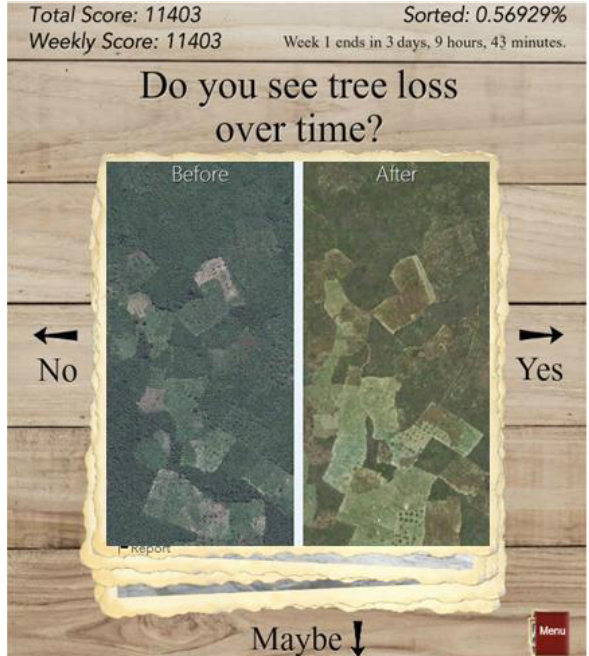
Figure 1. A screenshot from the Picture Pile tool used for identification of forest